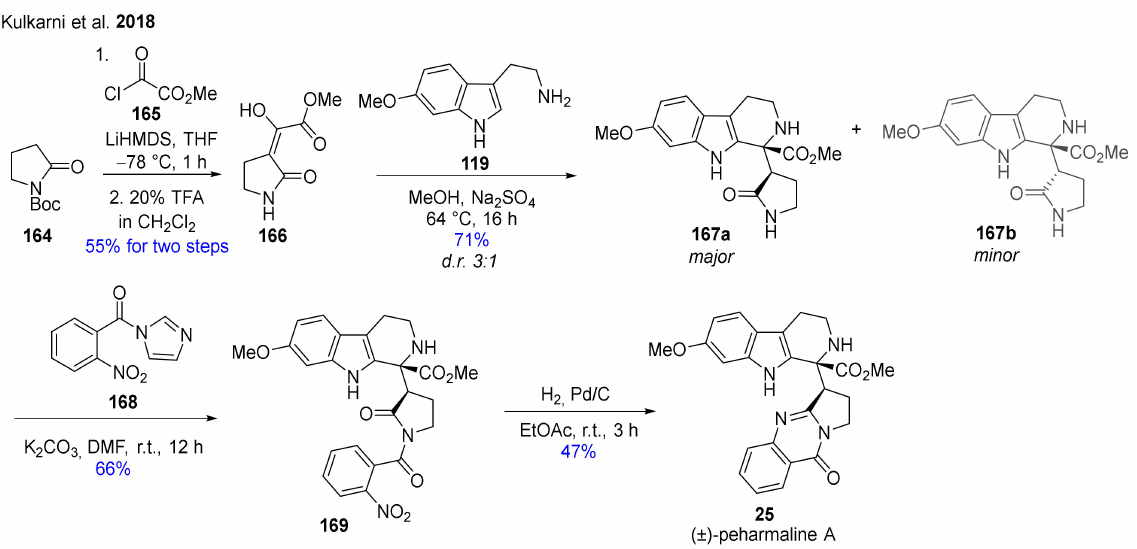
Scheme 13. Synthesis of ( ± )-peharmaline A ( 25